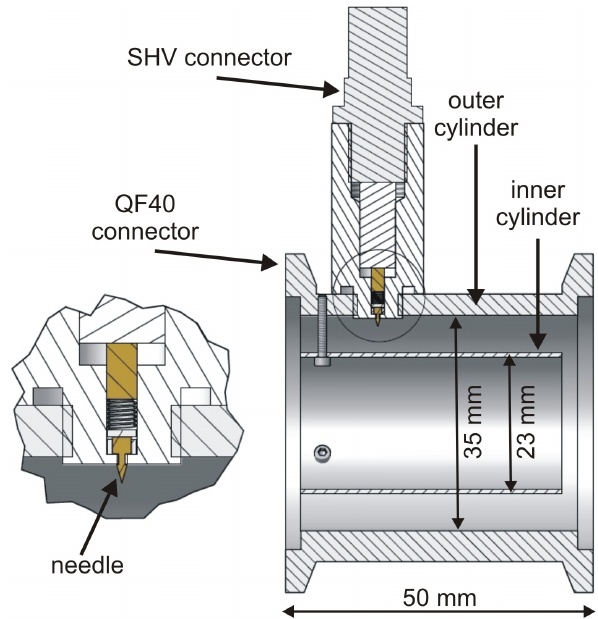
Fig. 2. Technical drawing of the new corona ion source set-up. The section on the left shows the magnified corona needle (in gold) and the compression spring which establishes the electrical contact to the SHV feedthrough. Direction of flows is from left to